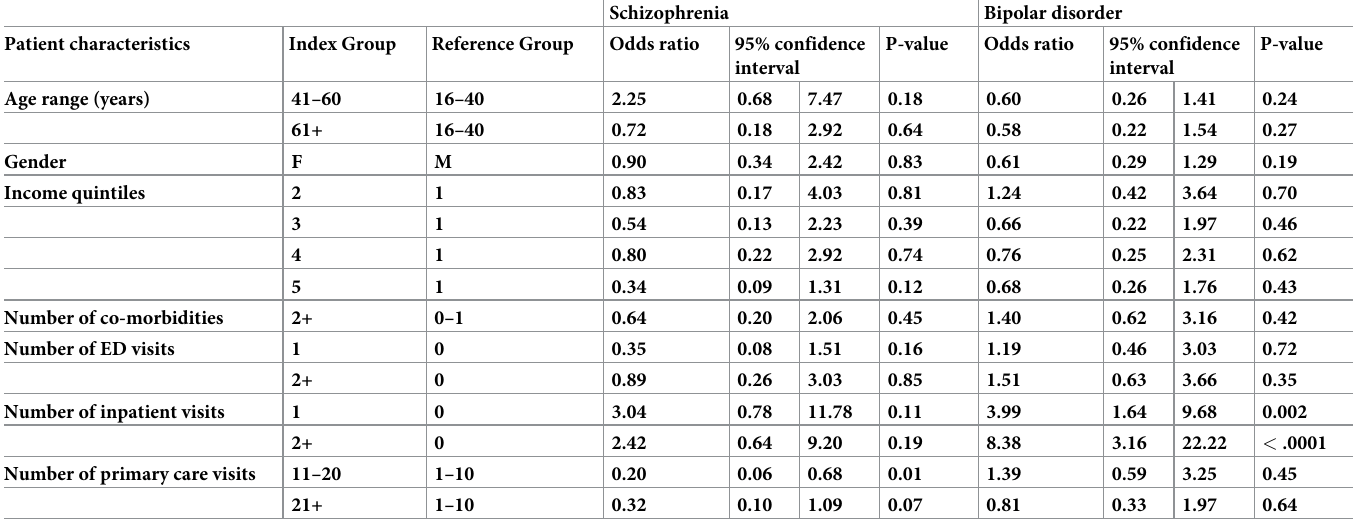
Table 3. Odds ratios for concordance among patients with schizophrenia and bipolar disorder. OR in bold are significant.